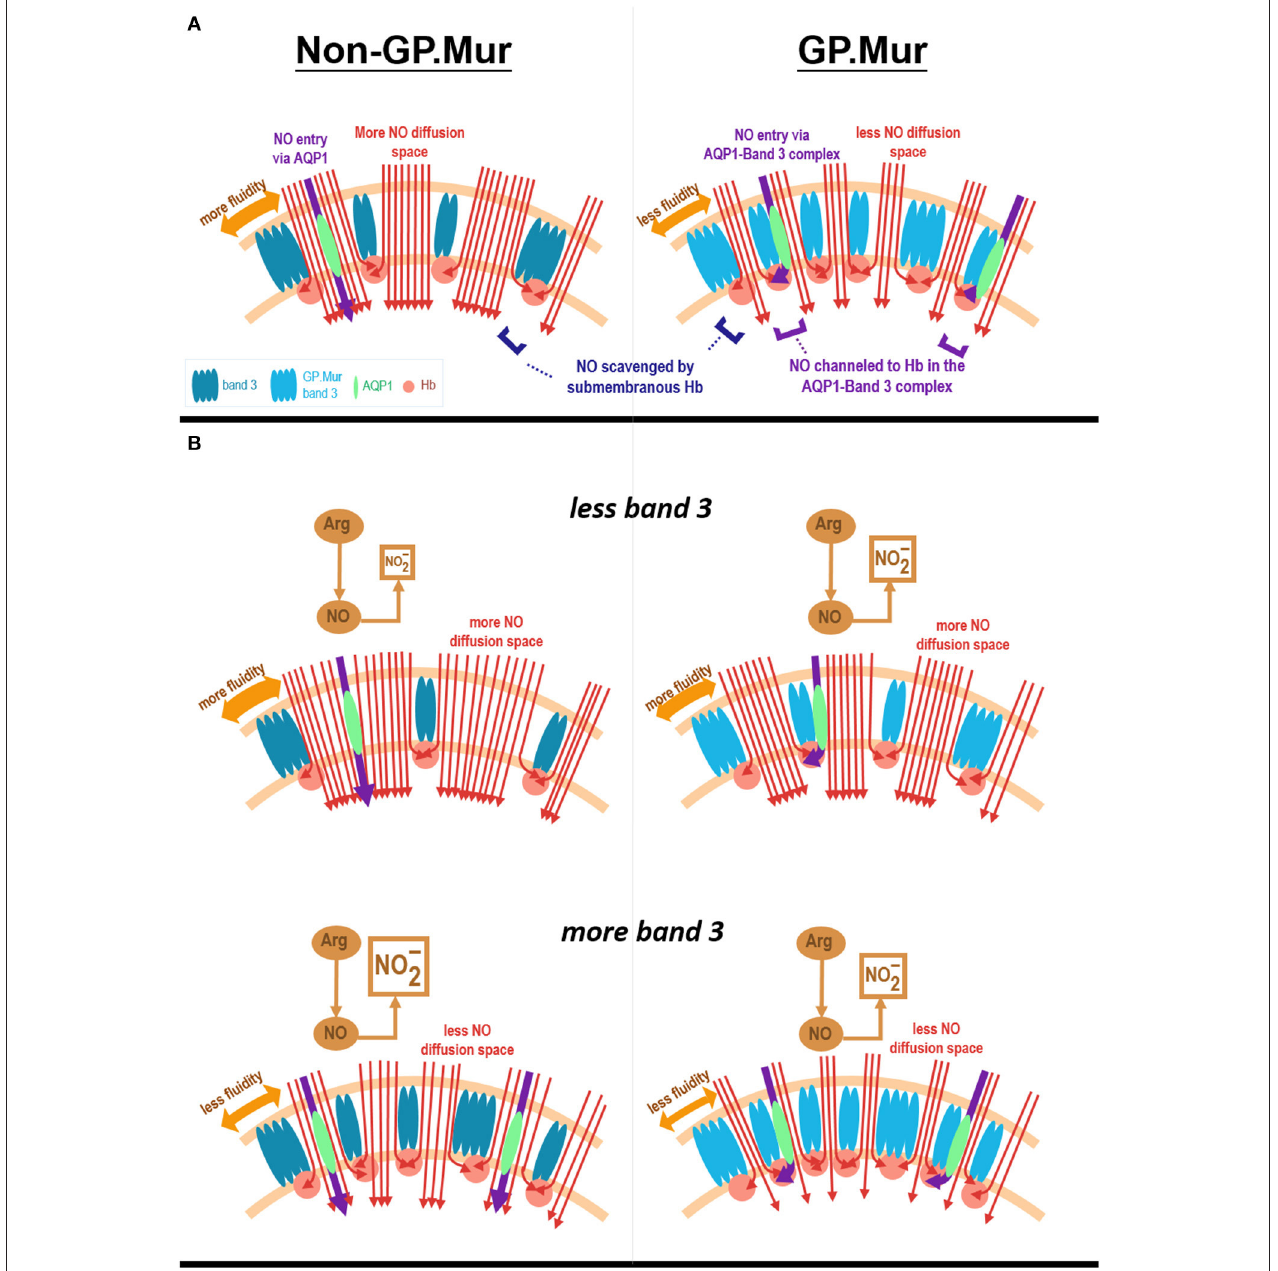
FIGURE 5 | Hypothesis. (A) A model depicts how Hb in GP.Mur + RBCs could be more effective in scavenging NO than Hb in non-GP.Mur RBCs. GP.Mur band 3 dimers and tetramers differ from non-GP.Mur in higher expression and distinct structural organization (labeled with different shades of blue color). Cytoplasmic band 3 binds Hb (red balls), preferentially less O 2 -saturated Hb. Because GP.Mur + RBCs express more band 3, there is more Hb lining on the inner leaflet of the lipid bilayer. In terms of protein complex organization, AQP1 (green) is mobile in non-GP.Mur RBCs but is often associated with band 3 in GP.Mur + RBCs. Their oligomerization on the GP.Mur + membrane enables channeling of NO to Hb through the AQP1-band 3 complexes (shown in purple arrows). Both structural differences equip GP.Mur + RBCs with a stronger suction for NO (red arrow lines). (B) A model depicts the relations between erythroid band 3 expression and plasma nitrite levels. Band 3 expression on the RBC membrane vary among individuals. The red cell membrane inserted with more band 3 protein tends to be less fluid and hence allows for less NO diffusion into the red cells (shown in red arrow lines). For non-GP.Mur (left panels), higher band 3 expression is associated with less NO entry and scavenge by erythrocytes; their plasma nitrite levels are thus higher. The content of plasma nitrite is complementary to the amount of NO scavenged by RBCs. For GP.Mur (right panels), NO diffusion into erythrocytes is not only affected by band 3 protein expression/membrane fluidity; GP.Mur + RBCs also scavenge NO more efficiently (as explained in A ). For GP.Mur, these two opposite effects conceivably even out and obscure the direct correlation between erythroid band 3 and plasma nitrite levels that was seen in non-GP.Mur.